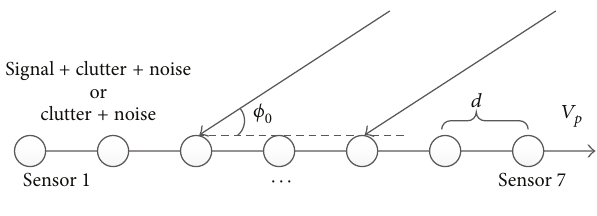
Figure 1: Shipborne line array.